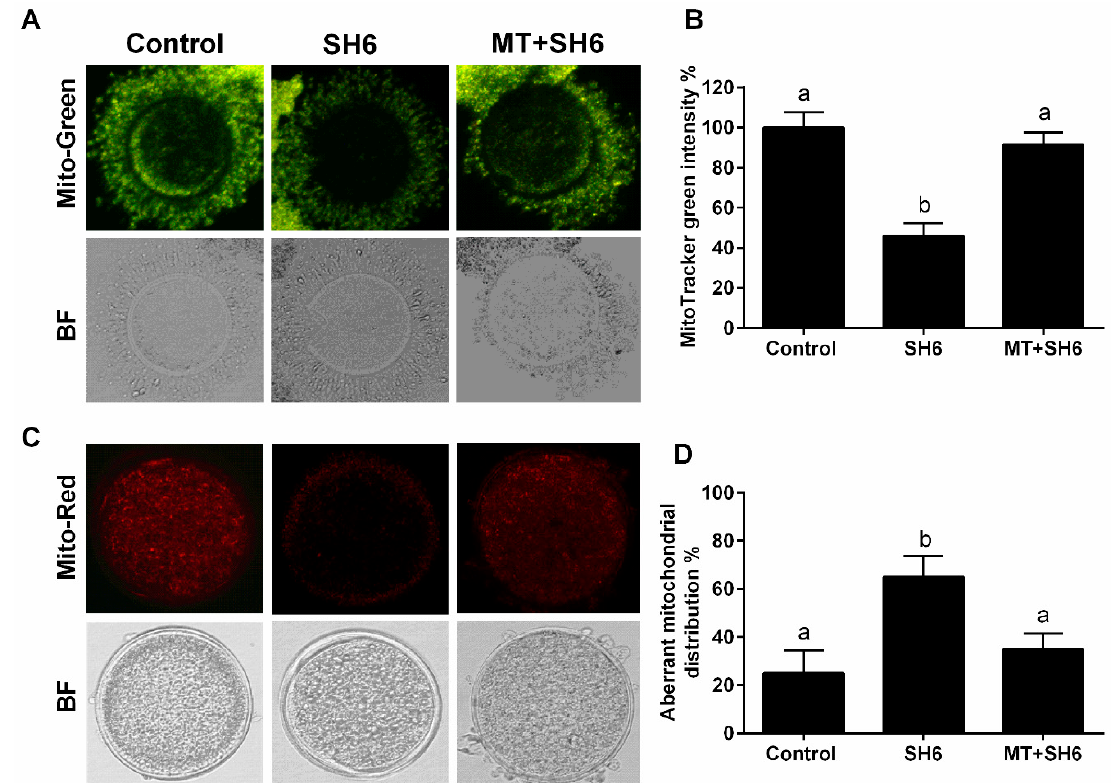
Figure 9. E ff ect of melatonin supplementation on mitochondrial membrane potential and mitochondrial distribution pattern in matured oocytes. ( A ) MitoTracker green fluorescence staining; ( B ) Integrated optical density; ( C ) Representative images of MitoTracker Red staining in matured oocytes; ( D ) Proportion of oocytes with aberrant mitochondrial distribution in each treatment group. BF: Bright Field. Values with di ff erent superscripts indicate significant di ff erences ( p < 0.05). Original magnification 200×.